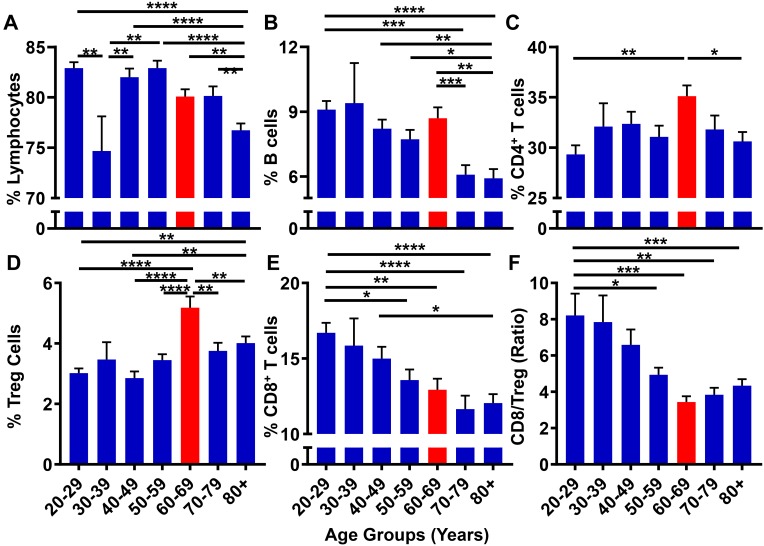
The peripheral blood CD8+ T/Treg ratio decreases with progressive aging in healthy human subjects. 10k immunomes CyTOF data from the peripheral blood of healthy patients analyzed for (A) total lymphocytes, (B) B cells, (C) CD4+ T cells, (D) CD8+ T cells, (E) Tregs (CD4+CD25+FoxP3+), and (F) CD8+ T/Treg ratio. Data was analyzed among age groups including 20–29 (n = 110), 30–39 (n = 14), 40–49 (n = 76), 50–59 (n = 78), 60–69 (n = 72), 70–79 (n = 57), 80+ (n = 127). ∗P < 0.05; ∗∗P < 0.01; ∗∗∗P < 0.001; ∗∗∗∗P < 0.0001.